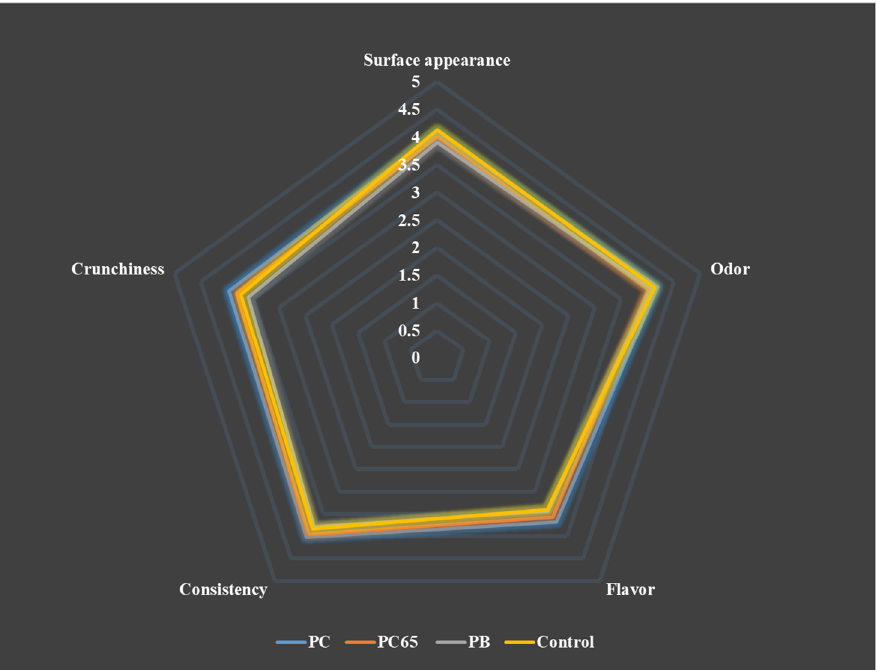
Figure 6. Evaluation of the sensory attributes of the snack bars. Here, 1 = “dislike extremely”, 2 = “dislike slightly,” 3 = “neither like nor dislike,” 4 = “like slightly,” and 5 = “like extremely”. No statistically significant differences were recorded among sensory attributes of four formulations ( p > 0.05); however, flavor and crunchiness showed highest values for standard deviation. For four samples that were evaluated, average values were recorded between 3.4 and 4.1, which corresponded to “neither like nor dislike” and “like slightly,” respectively. The trend showed that PC snack was highly accepted by the panelists, with an overall average value of 3.95. None of the samples received the maximum scale punctuation (5, “like extremely”). This suggested that formulations must be improved further to increase the score in sensory analysis, even though all the snacks could be considered as an acceptable meal option as per current